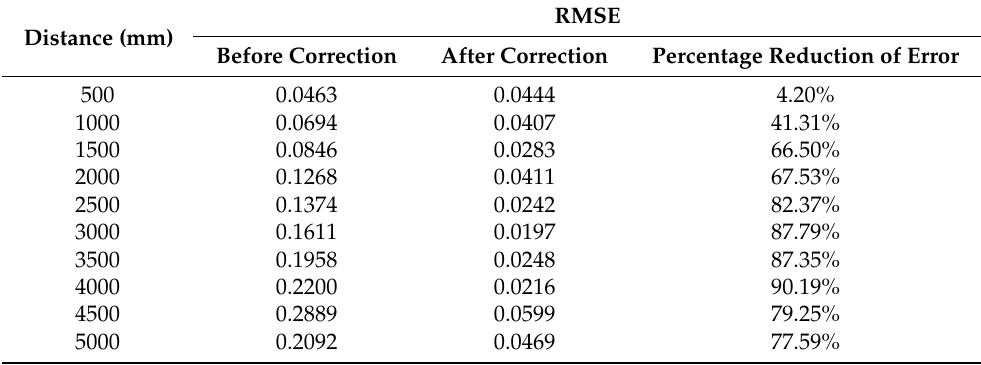
Table 2. Compensation effect of the optimal model on the checkerboard at different distances.